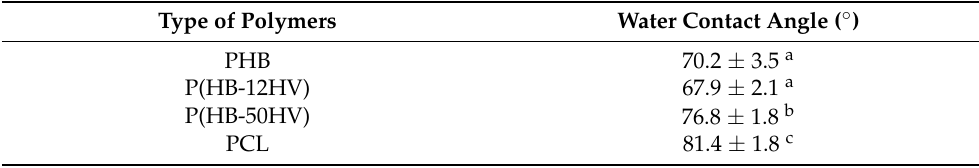
Table 1. Surface hydrophilicity of the polymer